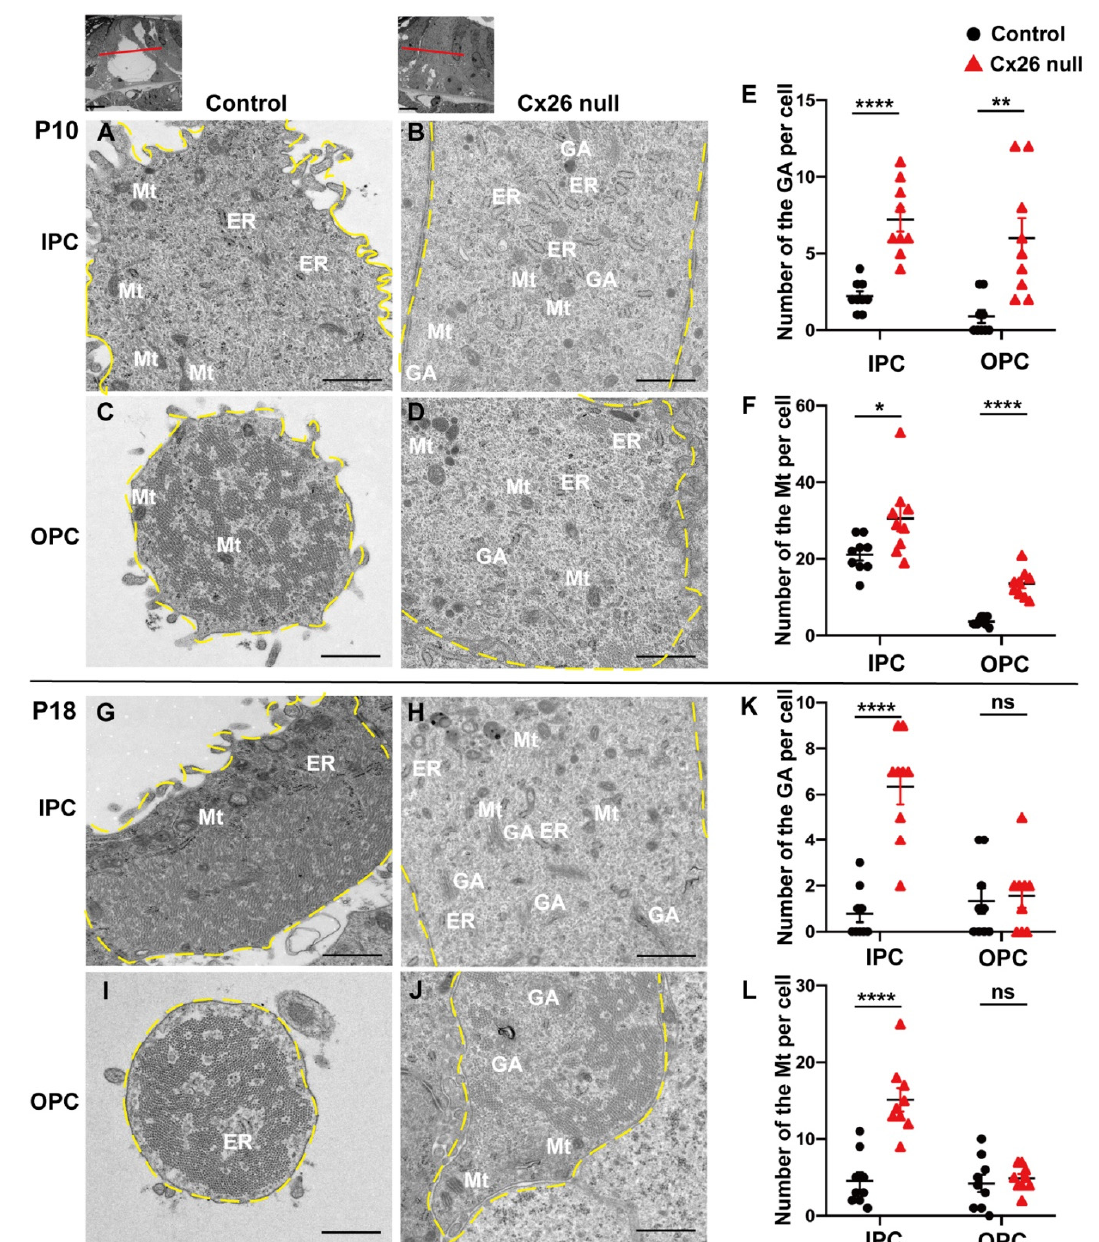
Figure 2. Impaired degradation of organelles in PCs and hypertrophy of PCs in Cx26-null mice. ( A – D ) TEM cross-sections obtained from the middle turn in the cochlea show the ultrastructure of IPCs and OPCs at P10; ( E , F ) Quantifications of the changes of the Mt and GA at the middle turn in